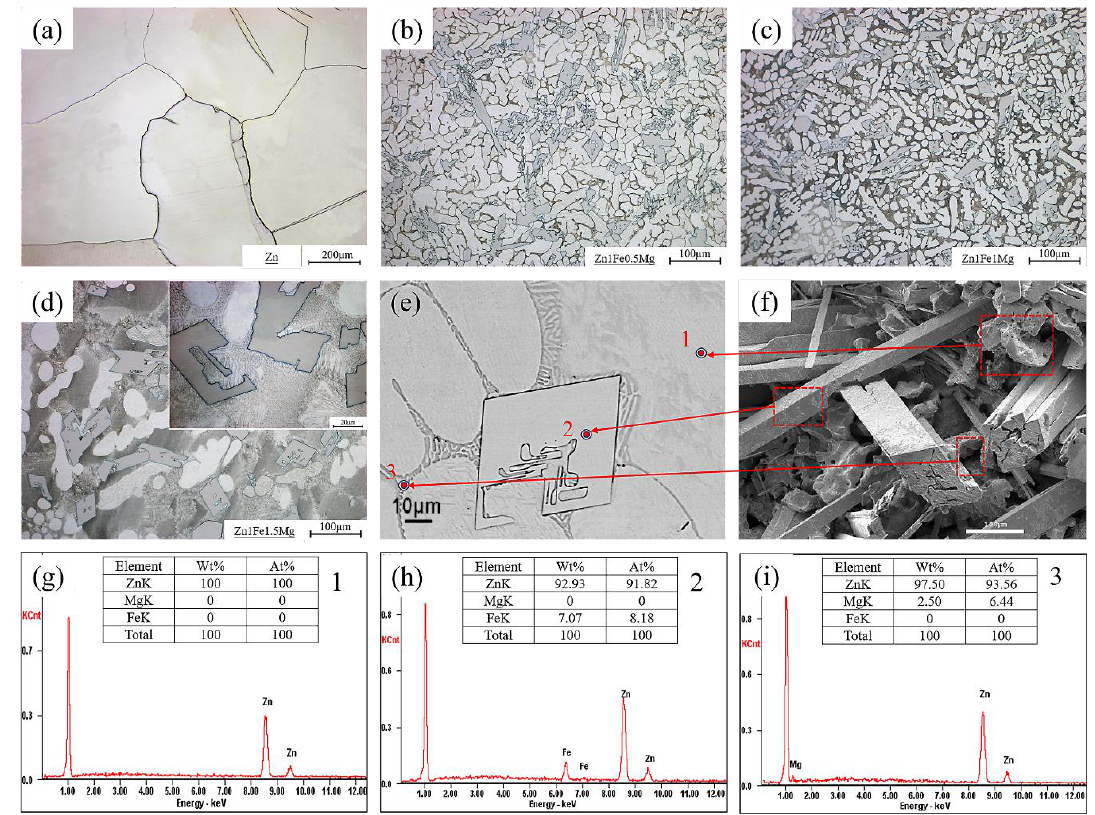
Figure 1. Micrographs of alloys with different Mg contents and results of energy dispersive spectroscopy (EDS) analysis: ( a )cast Zn, ( b ) Zn-1.0Fe-0.5Mg, ( c ) Zn-1.0Fe-1.0Mg, and ( d ) Zn-1.0Fe-1.5Mg, ( e ) morphology of the Zn1Fe0.5Mg alloy in the scanning electron microscopy (SEM) image; ( f ) the surface morphology of Zn1Fe0.5Mg after removing the corrosion products; ( g – i ) the EDS composition analysis of the points corresponding to the positions 1, 2, and 3 of ( e ), respectively.